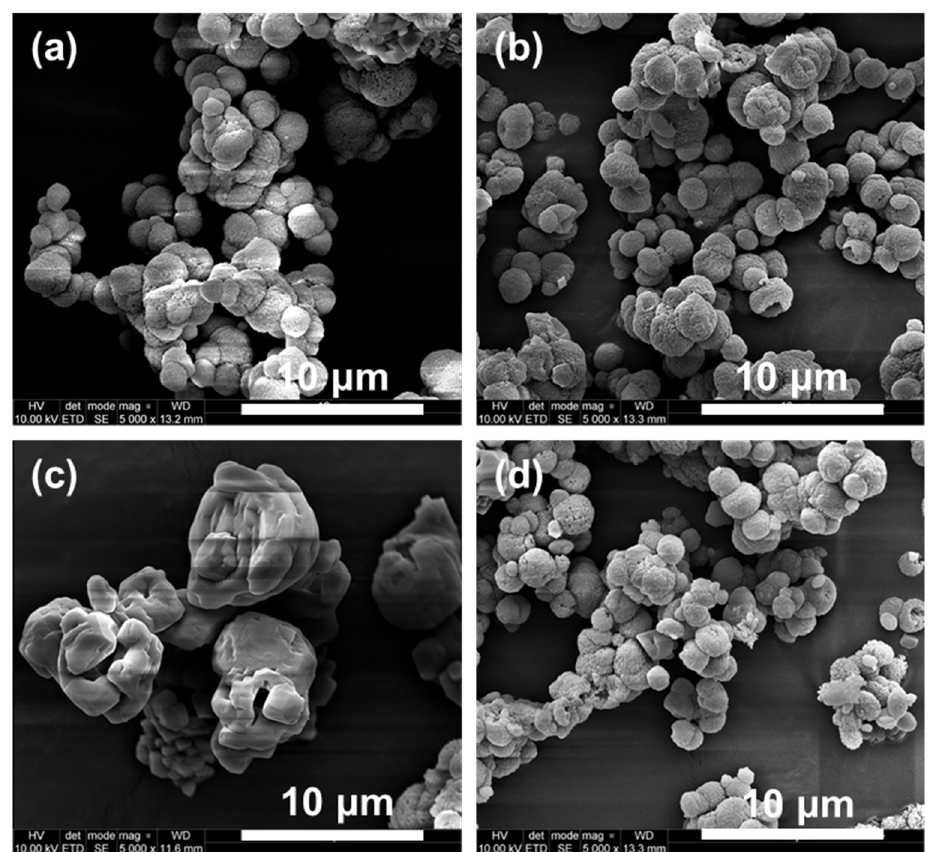
Figure 4. SEM photographs of non-incubated CaCO 3 particles precipitated without additives ( a ) and in the presence of 15% of DMSO ( b ), isopropanol ( c ) and methanol ( d ).